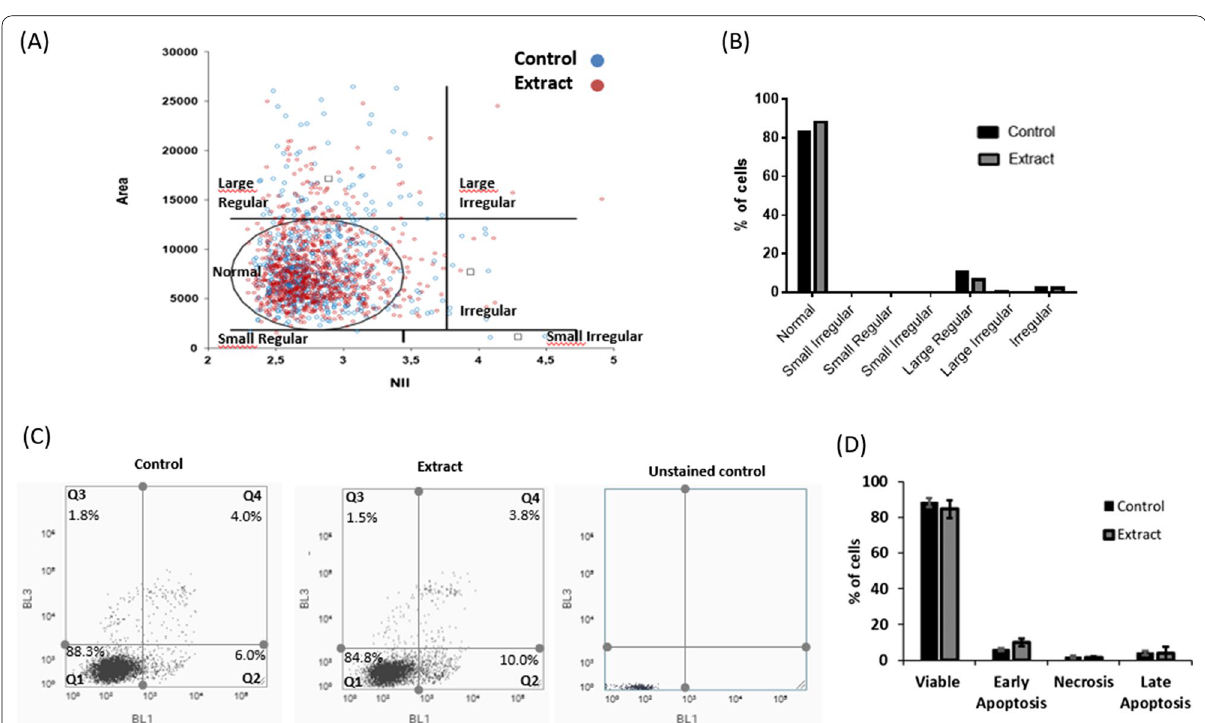
Fig. 3 F. hepatica extract did not alter parameters of nuclear morphometry, apoptosis, cell death of FLS. A Nuclear morphometric analysis was performed in FLS cell after 48 h culture with F. hepatica extract (100 mg/mL). Representative analysis in parameters of area, roundness, aspect, radius ratio, area box, and the nuclear irregularity index NII in parameters of nuclear irregularity when compared with the untreated group. Red dots: control; blue dots: F. hepatica extract; (n 3) B Percentage of positive cells for viability parameters (n 3). C Representative flow cytometry analysis = = of apoptosis (Annexin V-FITC, BL1 axis) and necrosis (propidium iodide, BL3 axis); Control (left) and treated (right). Nonstained control is also showed. Q1 (Annexin-/PI-): viable cells; Q2 (Annexin /PI-): early apoptotic cells; Q3 (Annexin-/PI ): necrotic cells; Q4 (Annexin /PI ): late apoptotic cells; + + + + D Percentage of viable, apoptotic, and dead cells (n 4). Data are expressed as mean = ±